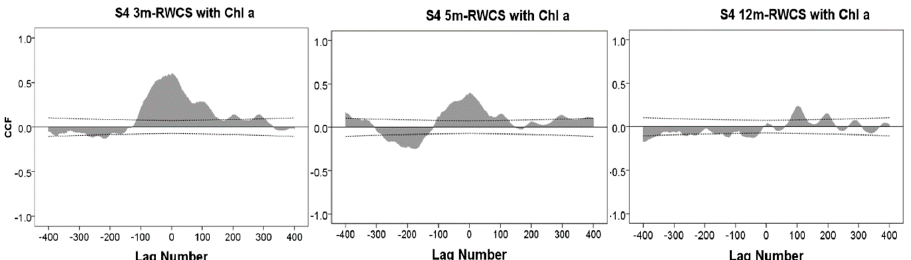
Figure 7. Cross-correlations between the relative stability of different water columns (3-m RWCS, 5-m RWCS, and 12-m RWCS) and Chl a at different stages according to the TN/TP ratio (the dotted line represents the confidence limit). RWCS represents the relative water column stability.